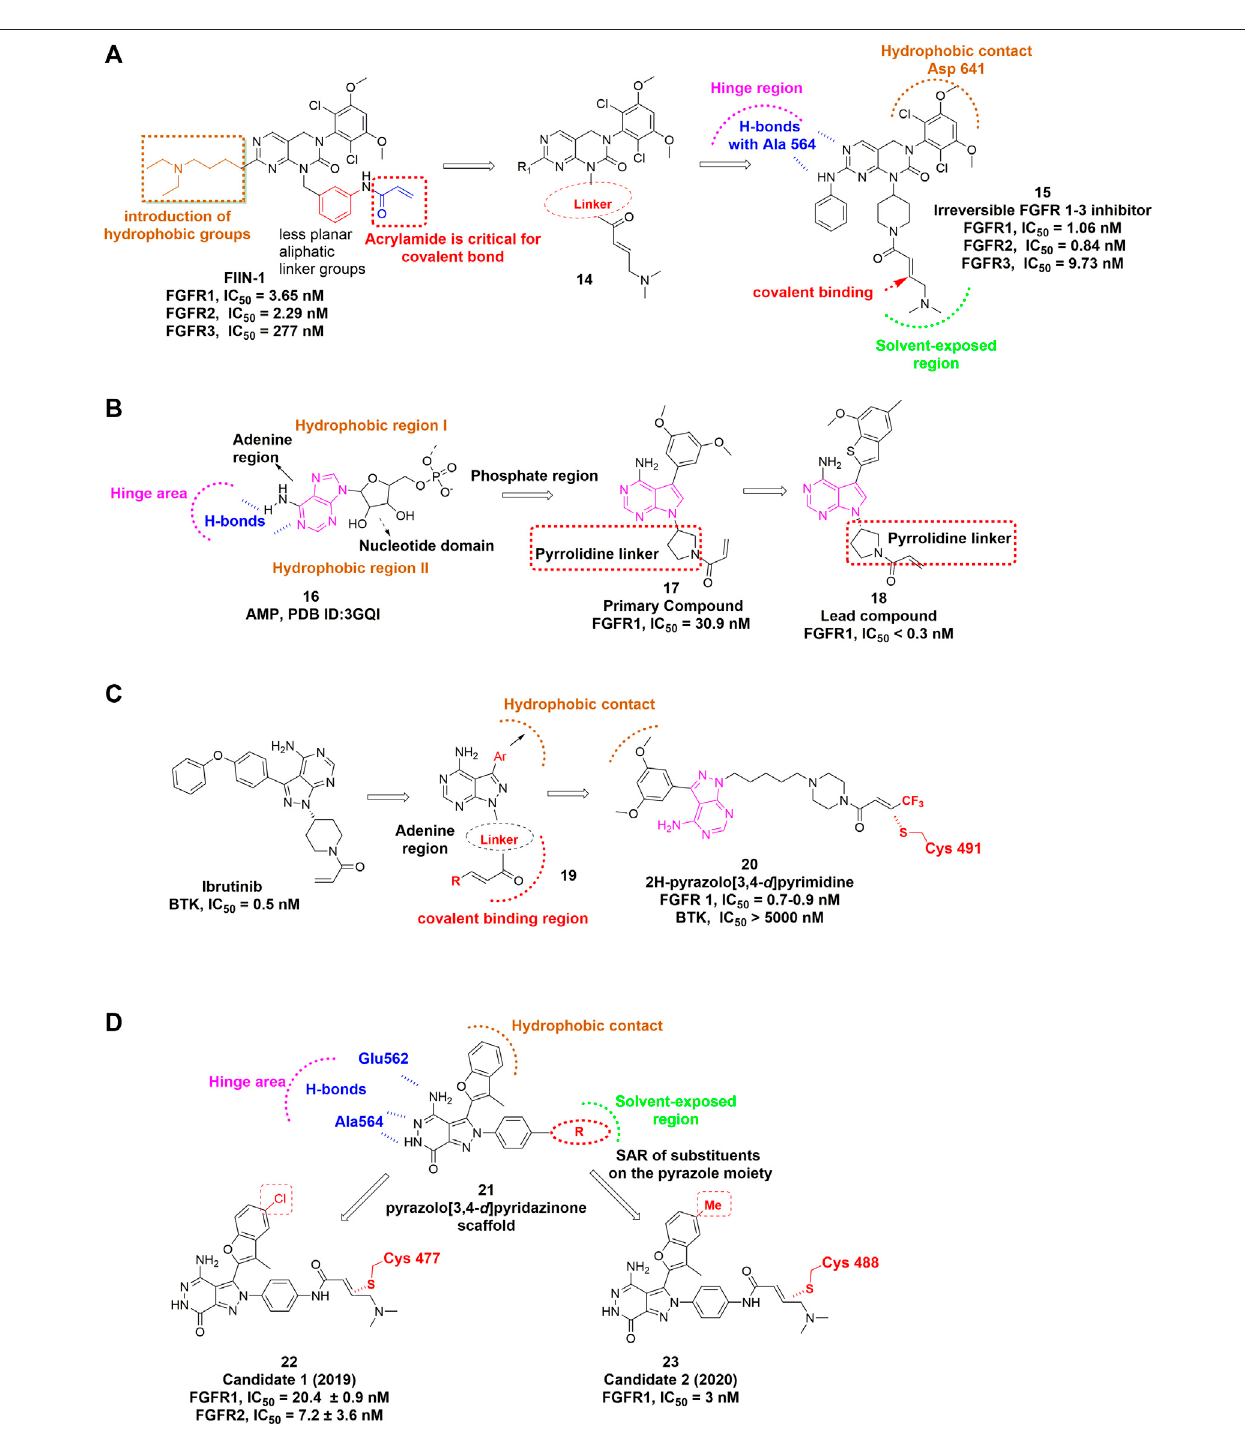
FIGURE 10 | (A) Structure optimization of FIIN-1. H-bonds are indicated by blue hashed lines. Hydrophobic interactions are outlined by hashed brown arc (PDB: 5B7V). The covalent bond-forming Michael acceptor carbon of the acrylamide is indicated by red arrow. (B) Discovery of irreversible inhibitors bearing novel pyrrolopyrimidinescaffold. (C) Discoveryof2H-pyrazolo[3,4- d ]pyrimidinederivatives.Hydrophobicinteractionregionisoutlinedbyhashedbrownarc.Covalentbinding region is highlighted by dashed red arc. (D) Covalent FGFR inhibitors bearing pyrazolo [3,4- d ]pyridazinone.